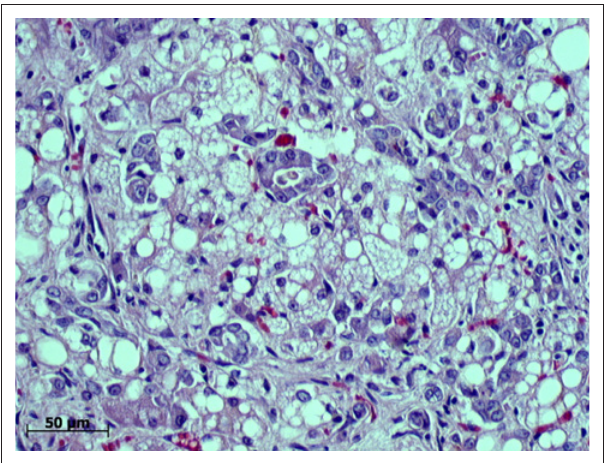
FIGURE 2: In canine aflatoxicosis, bile duct proliferation and fatty change were observed in the livers of all dogs ( n = 31) examined microscopically.